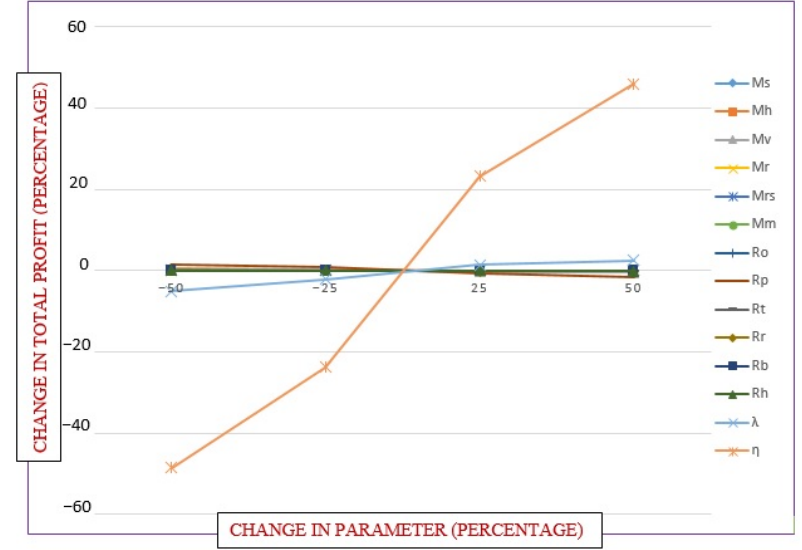
Figure 8. Effects of changes in parametric values versus total expected